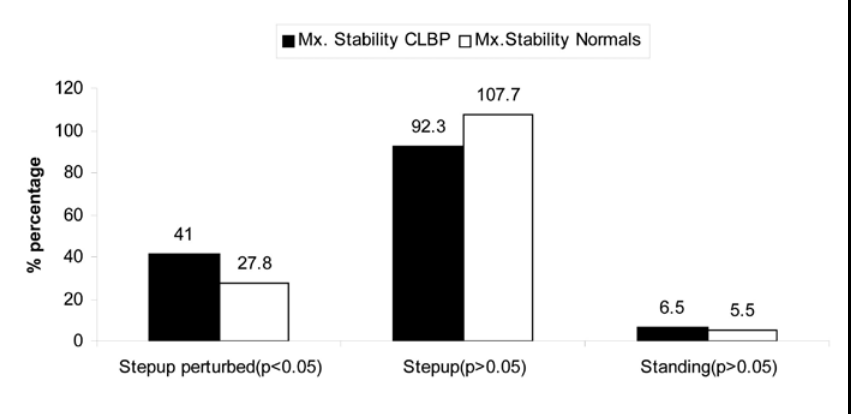
independent ‘t’ test results.